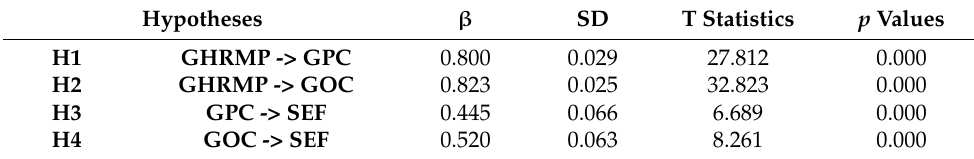
Figure 2. Factor loadings and direct path analysis. Table 6. Direct path